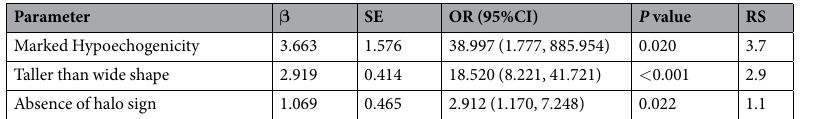
Table 3. Risk score of independent conventional US parameters in predicting malignant thyroid nodules according to multivariate logistic regression. β = regression coefficient; SE = standard error; OR = odds ratios; CI = confidence interval; RS = risk